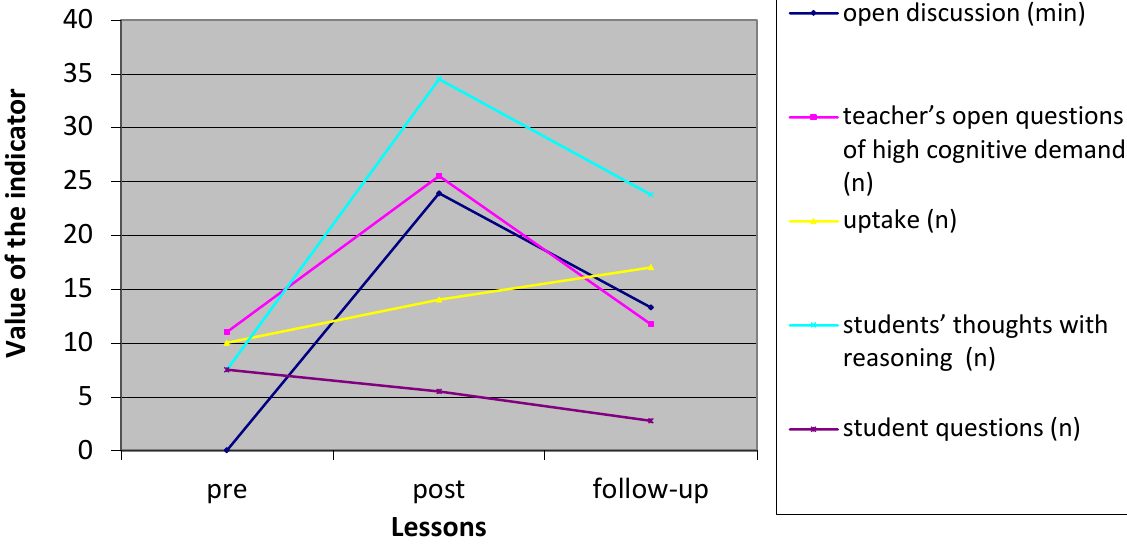
Figure 1: Comparison of pre, post, and follow-up lessons in indicators of dialogic